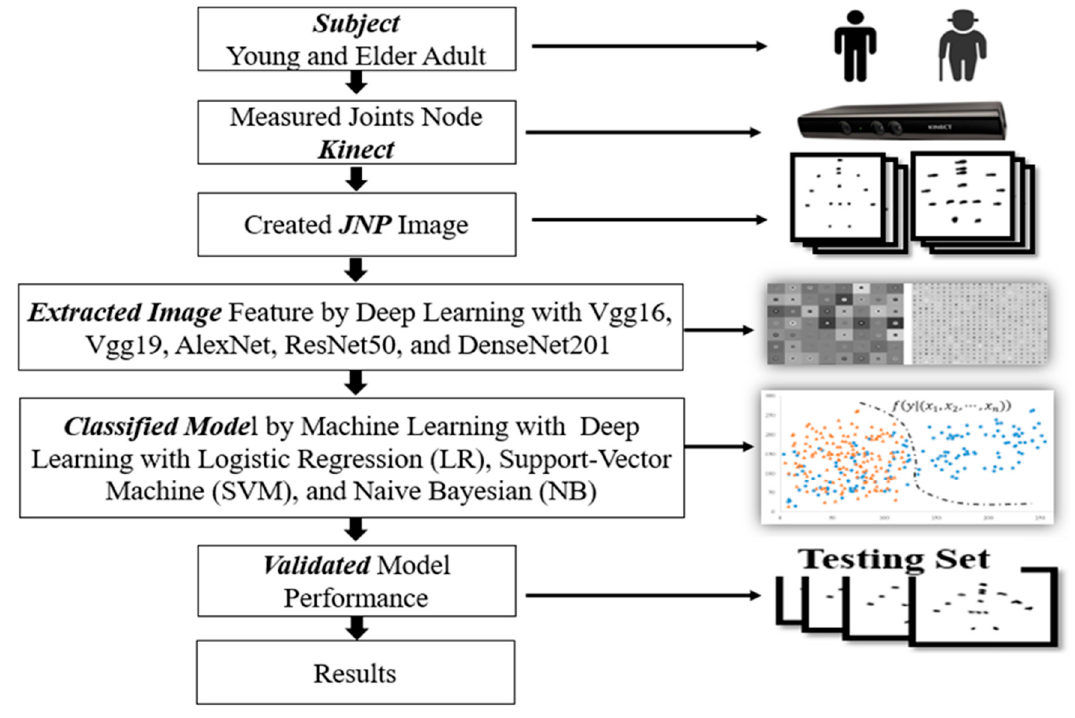
Figure 2. Study Figure 2. Study flowchart.